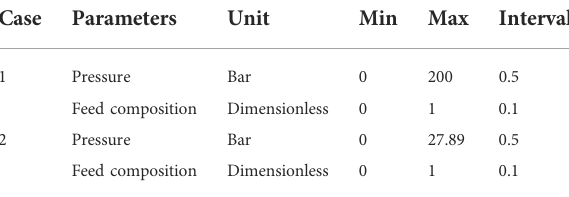
TABLE 2 The range of the input parameters of the training samples.